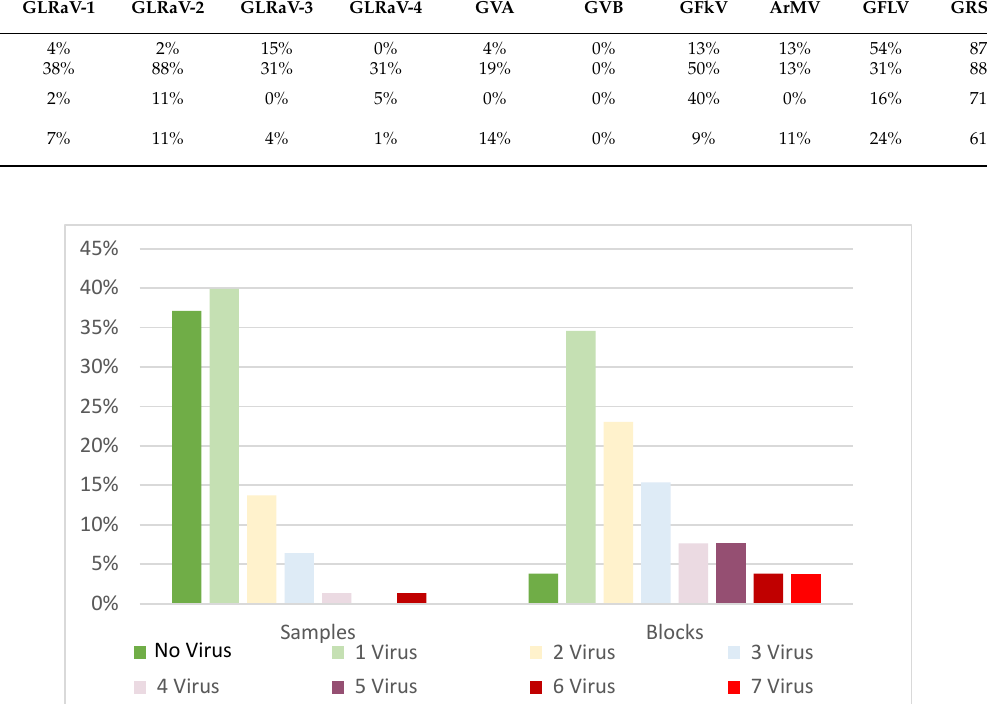
Table 3. Prevalence of grapevine viruses in composite samples from four regions surveyed. Region